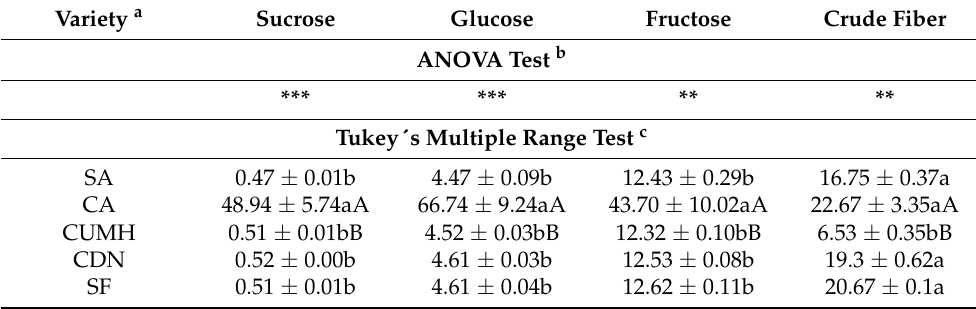
Table 2. Sugars profile [g Kg − 1 dry weight (dw)] and crude fiber content (%) of different varieties of Ficus carica leaves. Variety a Sucrose Glucose Fructose Crude Fiber ANOVA Test b *** *** ** ** Tukey ´ s Multiple Range Test